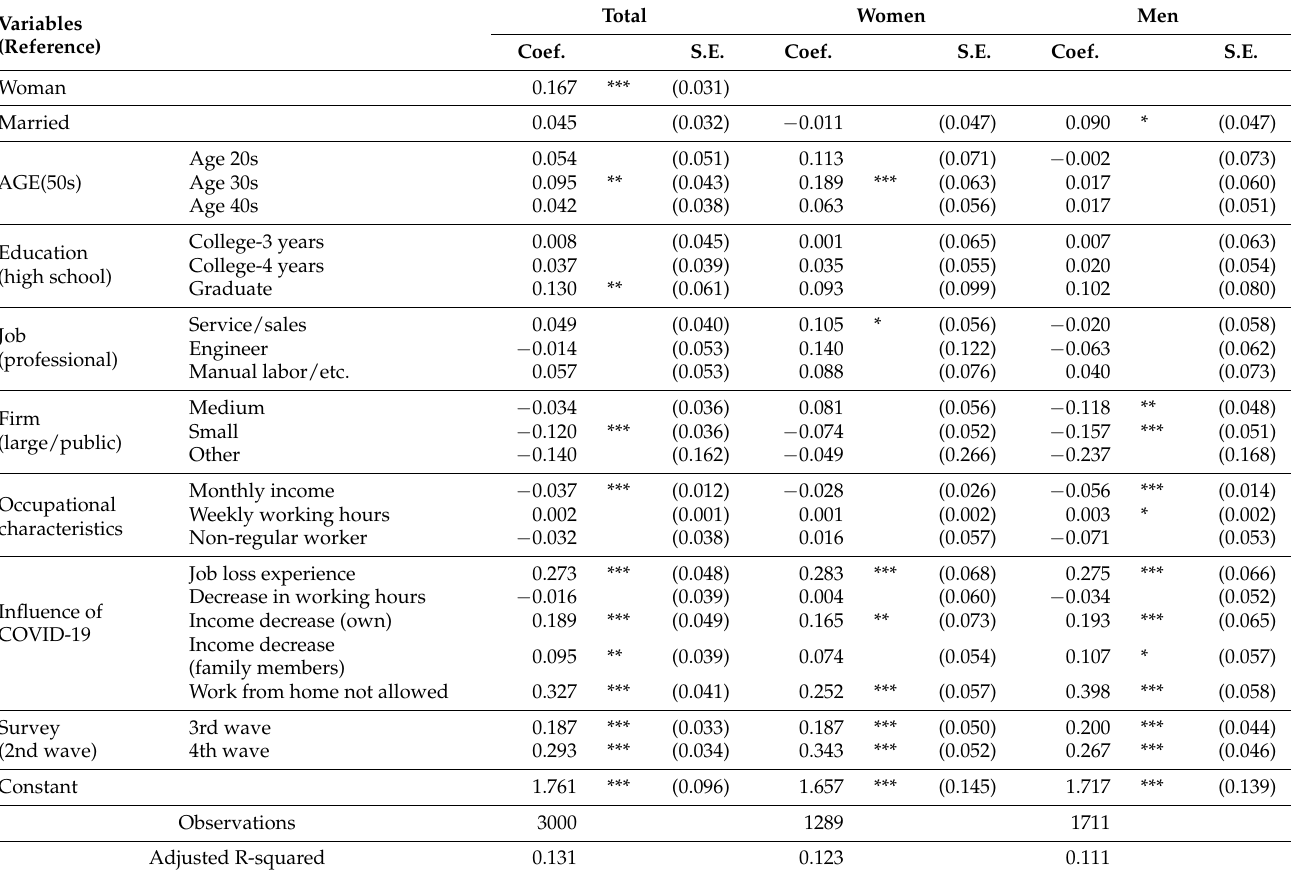
Table 2. Results of OLS regressions for